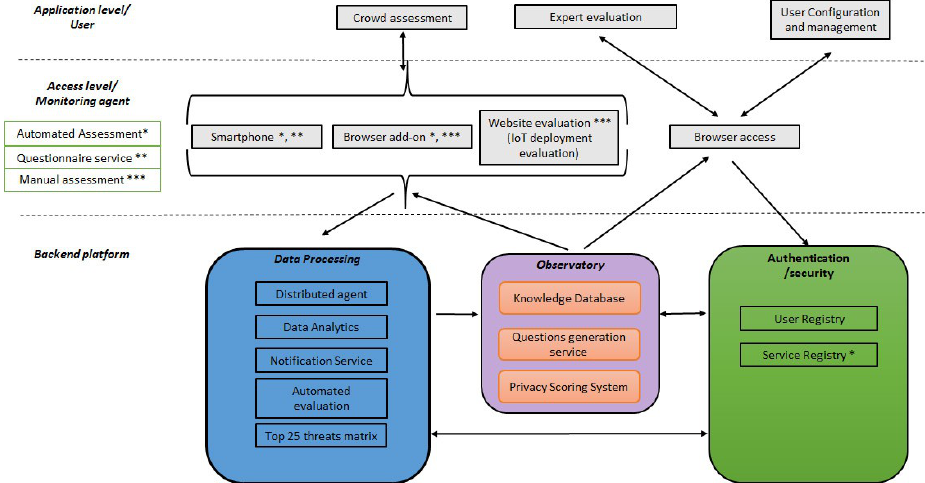
Figure 2. The position and role of the Observatory in the overall assessment